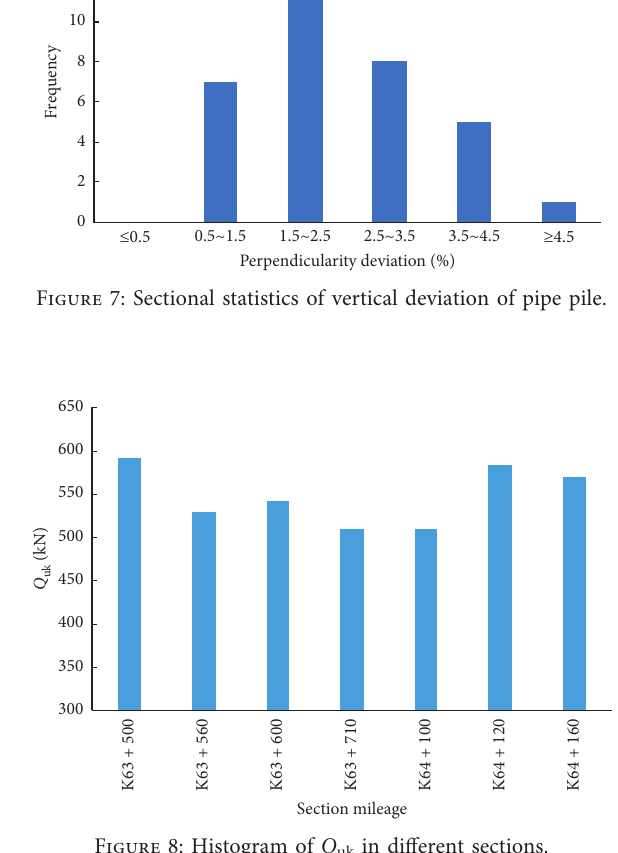
uk in different sections.